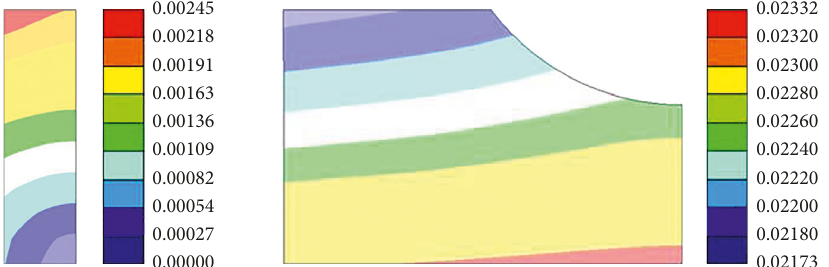
Figure 11: Displacement field (magnitude in millimeters)—model with shape